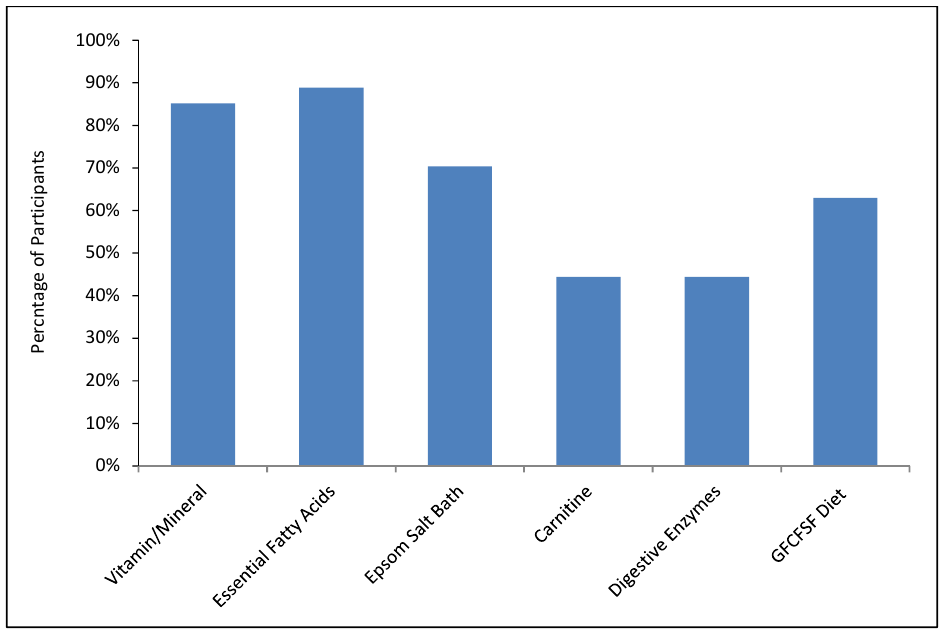
Figure 15. Percentage of participants who plan to continue each treatment.